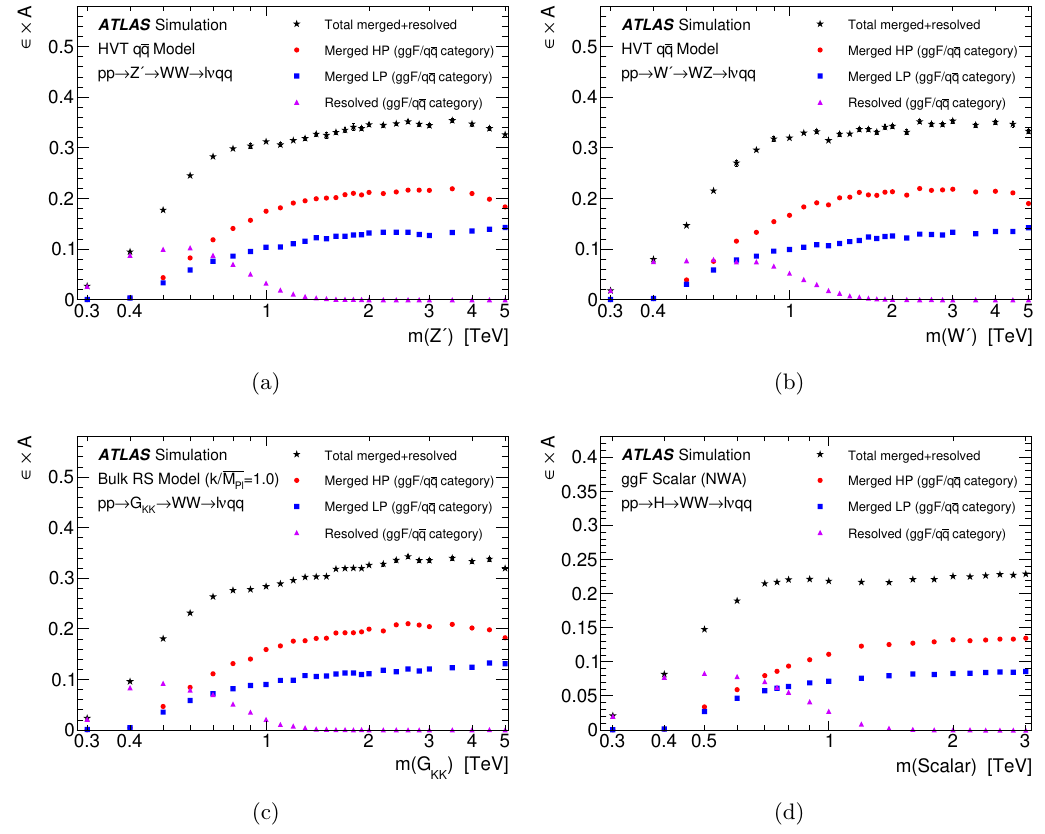
Figure 3 . The product of signal e(cid:14)ciency ( (cid:15) ) and acceptance ( A ) is presented in the ggF = q(cid:22)q category for signals produced via ggF or q (cid:22) q fusion. The (cid:15) (cid:2) A is presented for HVT (a) WW ! ‘(cid:23)qq , (b) HVT WZ ! ‘(cid:23)qq , (c) RS G KK ! ‘(cid:23)qq and (d) neutral scalar signal ( H ) decaying into ‘(cid:23)qq in the narrow-width approximation (NWA) in the various analysis categories. It is de(cid:12)ned as the ratio of the number of signal events reconstructed in the signal region to the number of generated signal